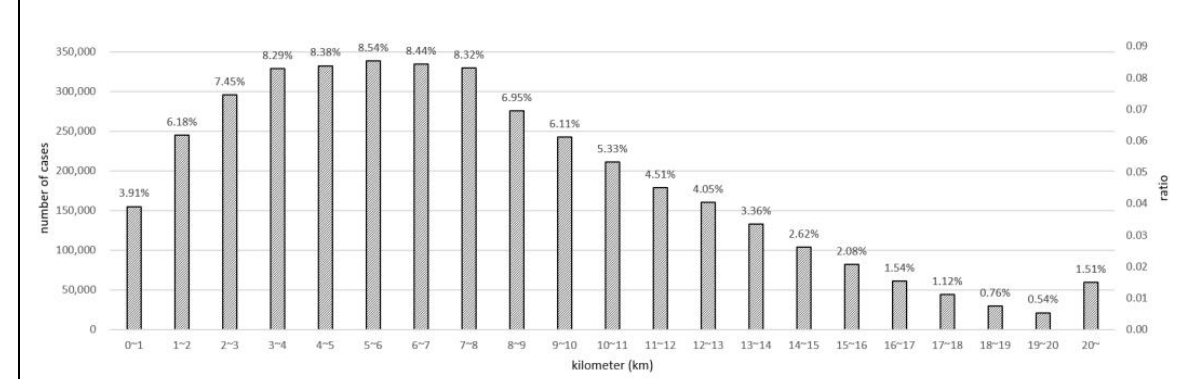
Figure 12. The number and ratio for node pairs regarding air distance.